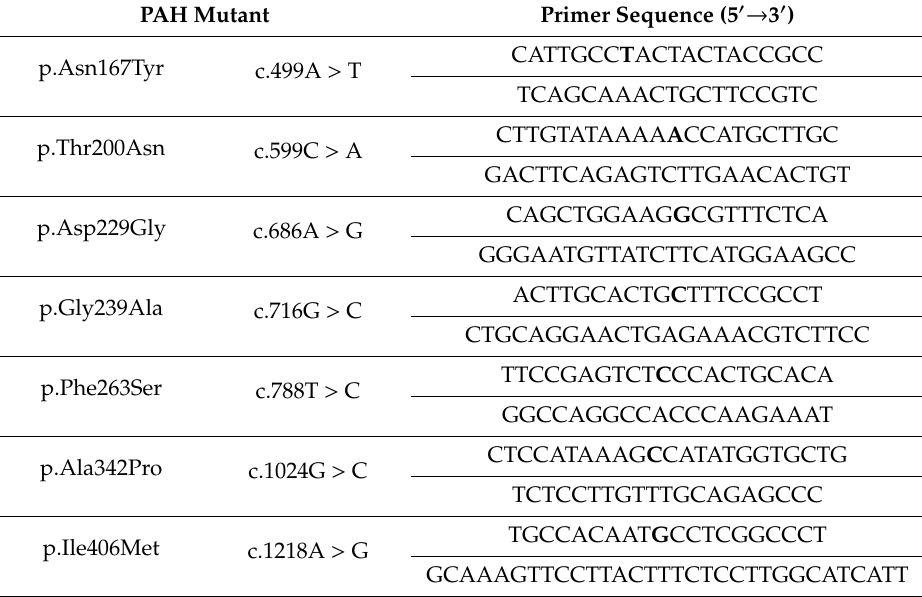
Table 1. The primers used for PAH mutants preparation using site-directed mutagenesis. Bolded nucleotide represents the substituted base. PAH Mutant Primer Sequence (5 (cid:48) → 3 (cid:48)